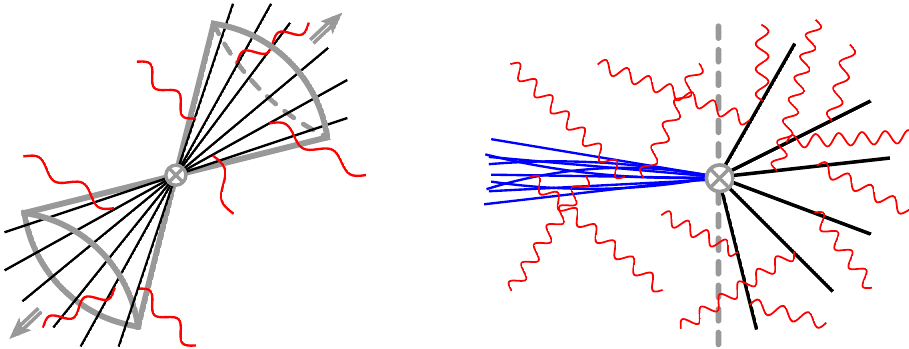
Figure 1 . Pictorial representations of factorization formulas for interjet energy (cid:13)ow (left) and jet mass (right), see (1.1) and (1.4). The black lines represent hard radiation with typical scale Q which is constrained to be inside the cones, and the red lines depict soft radiation with a low energy scale Q 0 which is allowed to populate the full phase space. In the right (cid:12)gure, the blue lines in the left hemisphere represent collinear radiation which is described by the inclusive jet function in